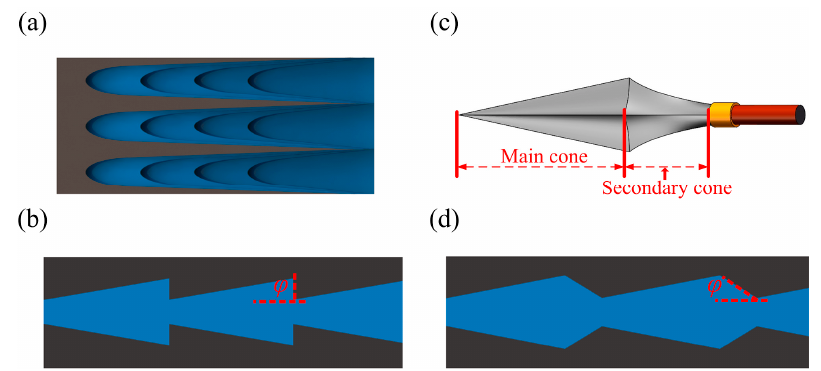
Figure 1. ( a ) The peristome surface of the pitcher plant. ( b ) Schematic diagram of a flat-bottom conical array. ( c ) A typical arrowhead structure that inspired the microstructure design. ( d ) Schematic diagram of arrowhead